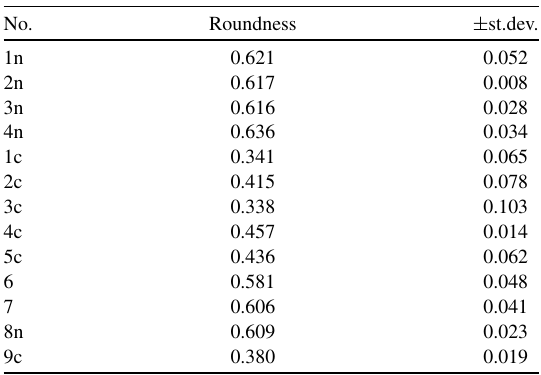
Roundness values of the linear part of the roundness function a No.